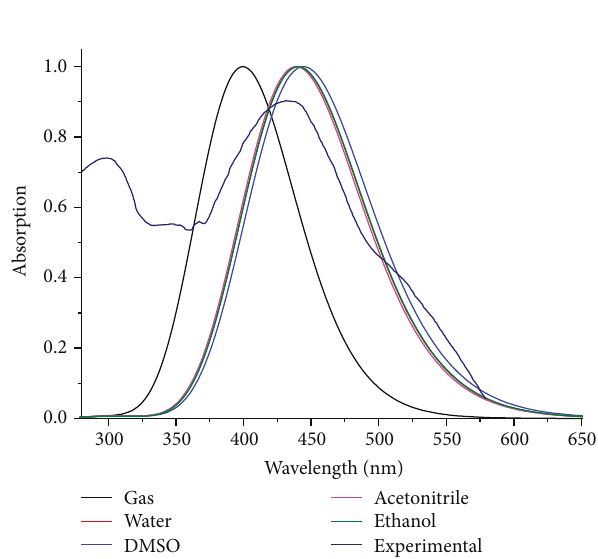
Figure 4: UV-Vis spectra of DMAB recorded by B3LYP/6-311G++ in di ff erent media with the experimental